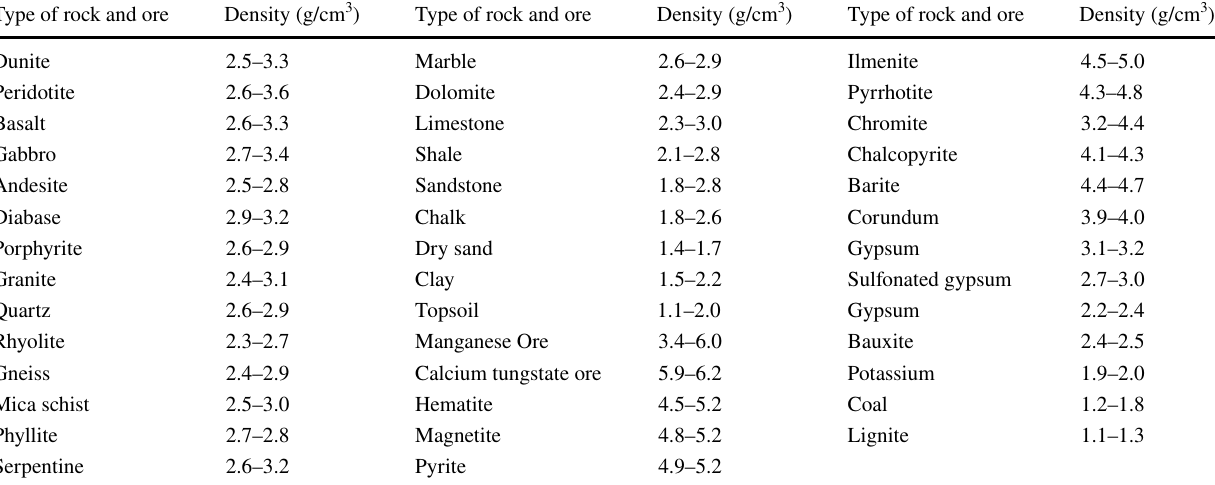
Table 1 Densities of different rocks and